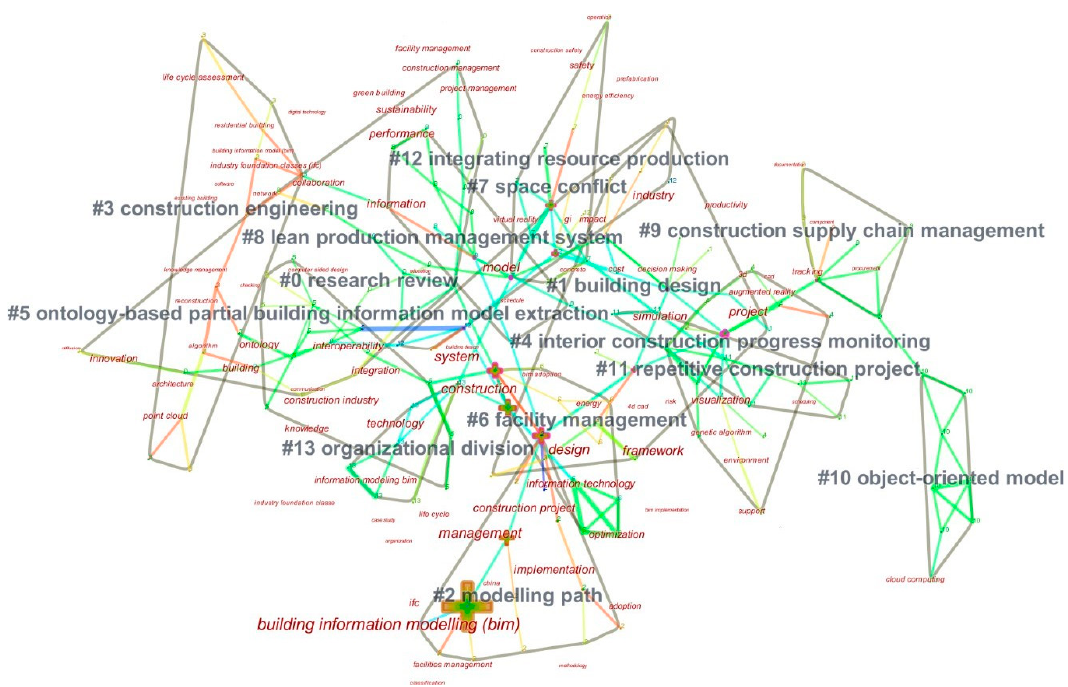
Figure 9. Network of co-occurring keywords- Clusters.